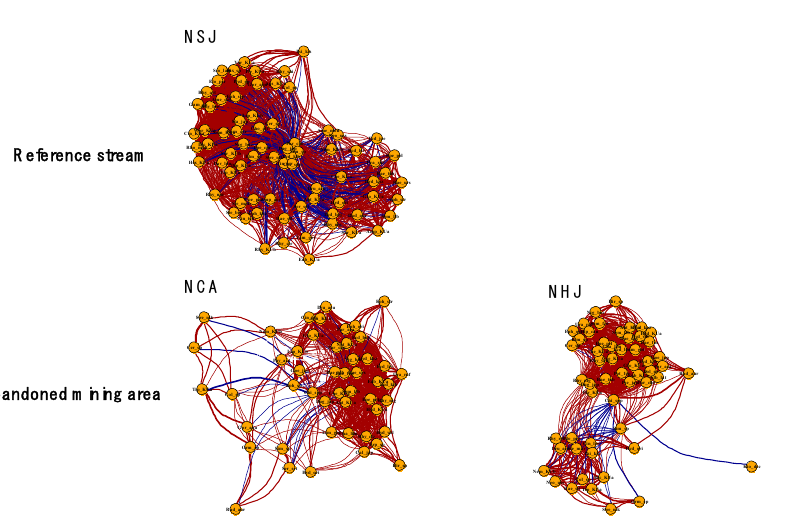
Figure 5. Co-occurrence networks among benthic macroinvertebrate species from streams located near abandoned mining area (NCA and NHJ) and reference stream (NSJ). Nodes indicates each species observed in each stream, and lines represent connections among species.